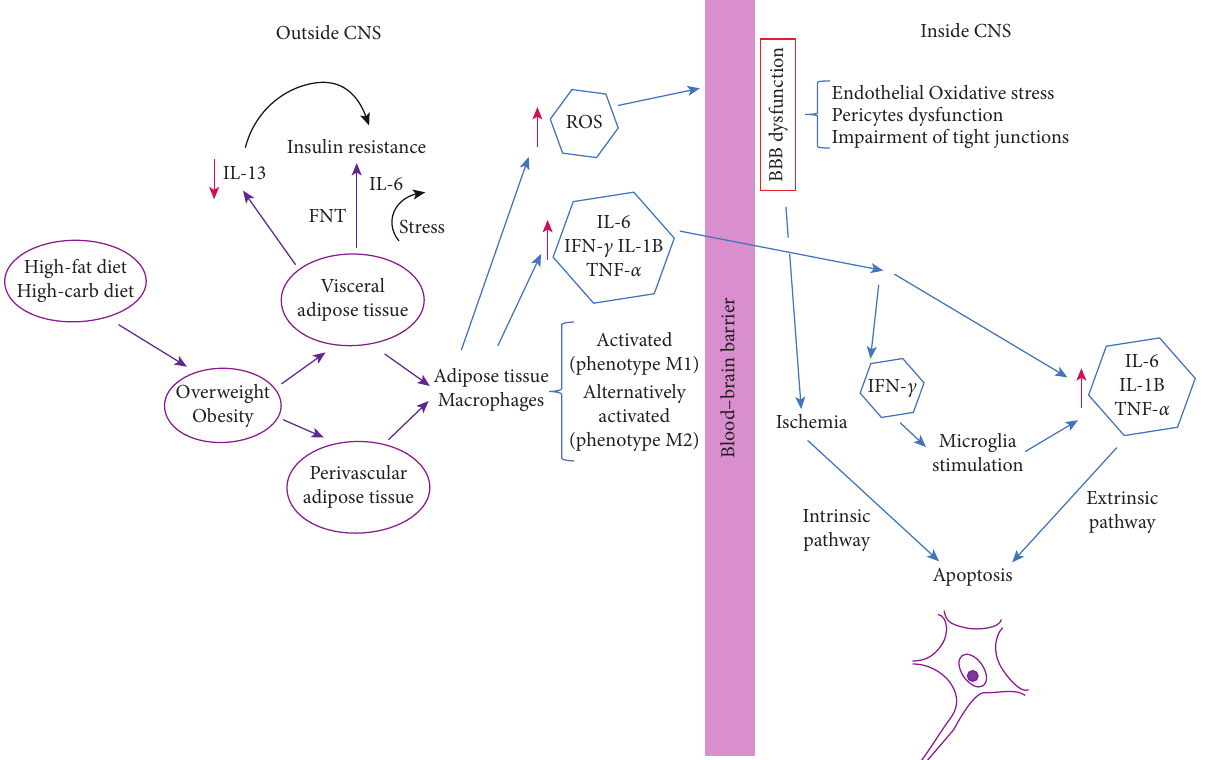
Figure 1: Pathogenesis of obesity-associated brain damage. Outside CNS: adipose tissue macrophages infiltrate the adipose tissue in obesity and contribute to insulin resistance. M1 or “classically activated” macrophages are induced by proinflammatory mediators, such as li- popolysaccharides and IFN- c . M1 macrophages enhance proinflammatory cytokine production (TNF- α , IL-6, and IL-12), which can block the effects of insulin action on adipocytes (link between inflammation and insulin resistance) and generate reactive oxygen species (ROS), such as nitric oxide, via activation of iNOS (Nos2). Inside CNS: local and systemic inflammation induced by obesity can cause breakdown of the blood-brain barrier (BBB), a decrease in waste removal, and an increase in infiltration of immune cells. Microglia: activated microglia secrete proinflammatory cytokines (IL-1 β , IL-6, TNF- α , and INF- c ), which stimulate inflammatory signaling in adjacent neurons, which in turn induces insulin and leptin resistance of